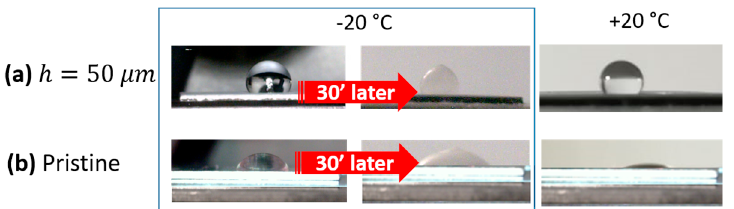
Figure 6. Droplet evolution after a thermal cycle. The 10 µL drop, gently set ( a ) on the micromachined sample ( h = 50 µm), is compared with the droplet ( b ) on the pristine one.